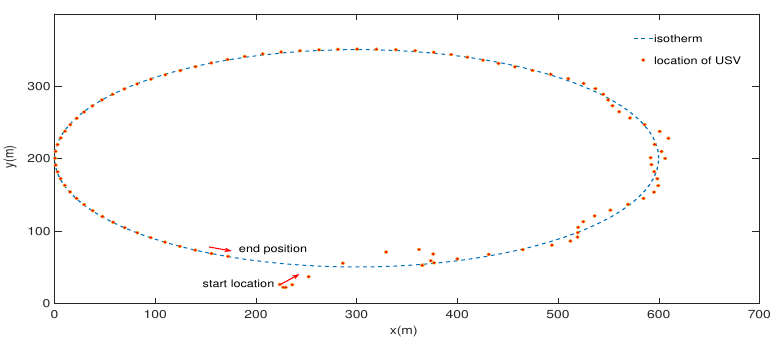
Figure 14. The location points of the USV without disturbance.